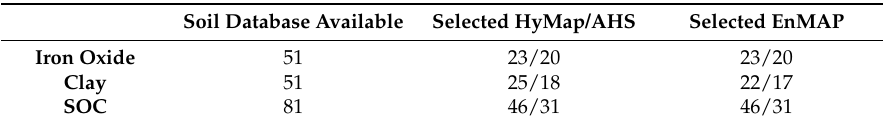
(cid:1) 1 (cid:4) kg ), clay (%) and SOC (g